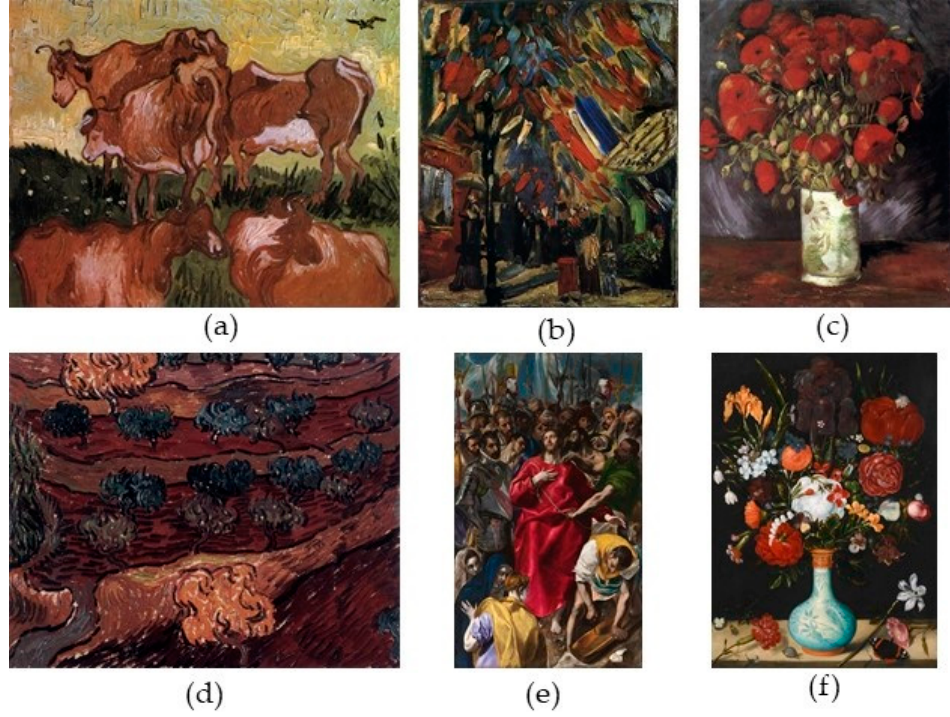
Figure 5. ( a ) Painting 1, ( b ) Painting 2, ( c ) Painting 3, ( d ) Painting 4, ( e ) Painting 5, and ( f ) Painting 6. Paintings 1–4 were created by Vincent van Gogh, Painting 5 by El Greco, and Painting 6 by Ambrosius Bosschaert.